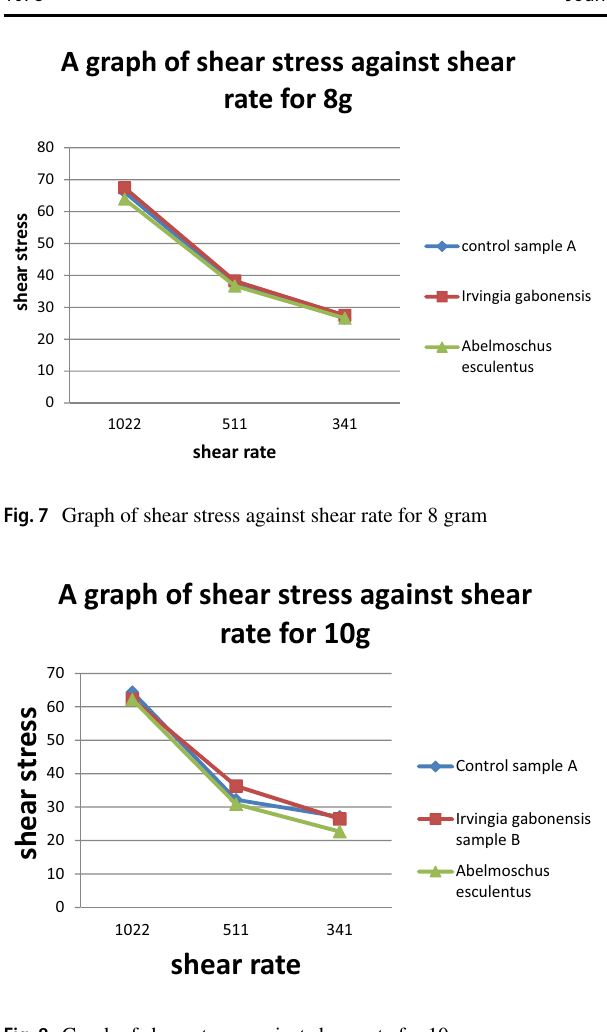
Fig. 8 Graph of shear stress against shear rate for 10 g